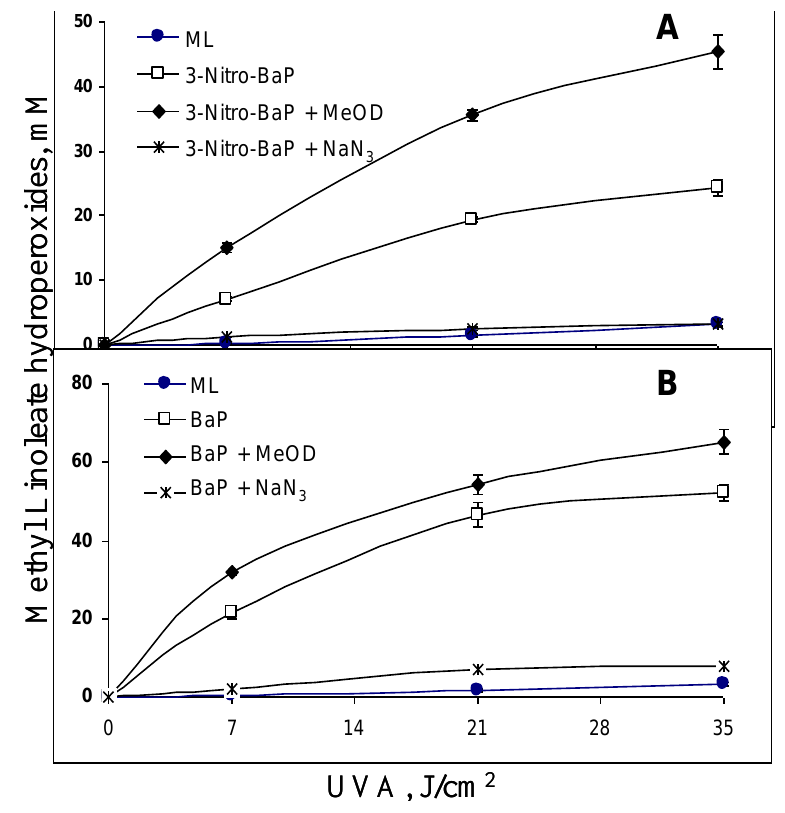
Figure 5. Effects of NaN 3 and CH 3 OD on peroxidation of methyl linoleate (ML) initiated by ( A ) 3-nitro-BaP, and ( B ) BaP in CH OH under UVA 3